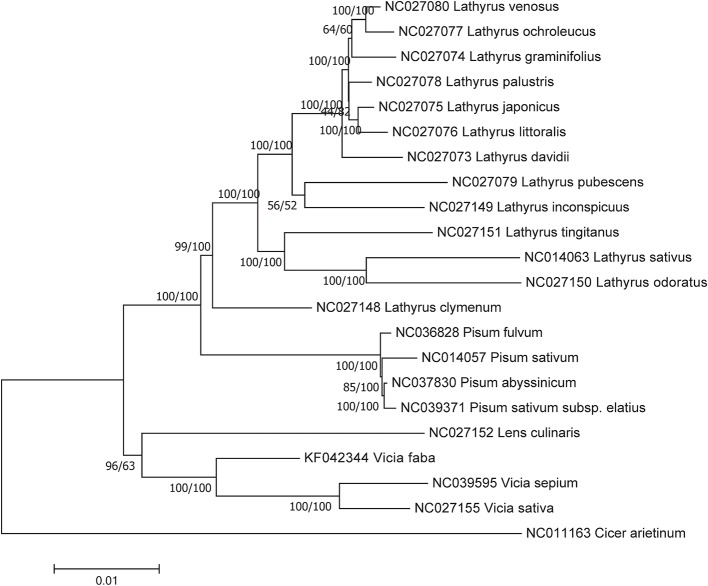
Phylogenetic relationships based on the conserved chloroplast protein-coding sequences of 21 Fabeae species and C. arietinum with the maximum likelihood (ML) method and the neighbor joining (NJ) method. C. arietinum was selected as the outgroup. Numbers on the left and right side at the branches represent bootstrap values of the ML method and the NJ method respectively.